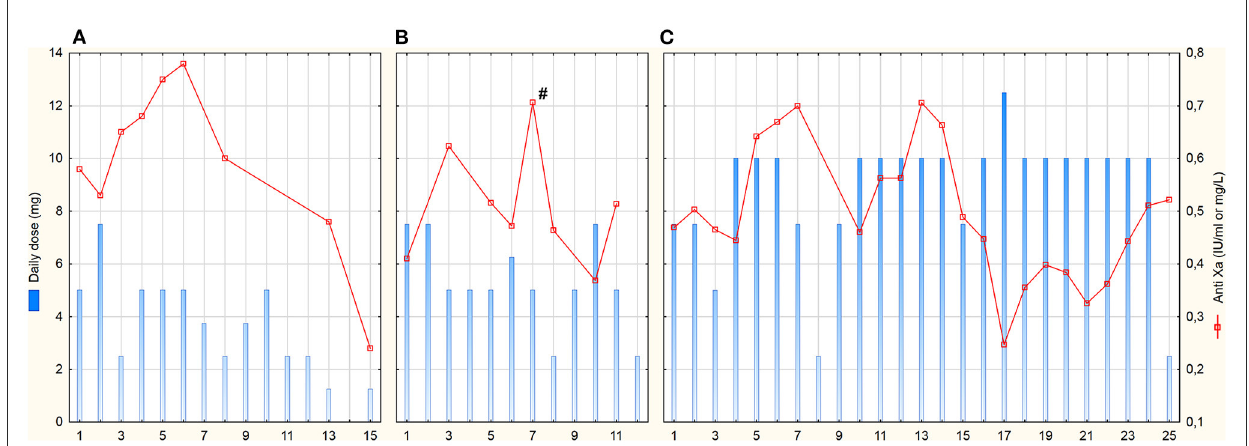
FIGURE1 Daily fondaparinux doses and anti-Xa trough levels. Anti-Xa in IU/mL for patient (A) (assay calibrated for low molecular-weight heparins), in mg/L for patients (B, C) ; # means peak anti-Xa 3h after administration (trough levels were taken max. 2h before the next dose); x-axis represents days after HIT diagnosis and commencement of fondaparinux treatment.